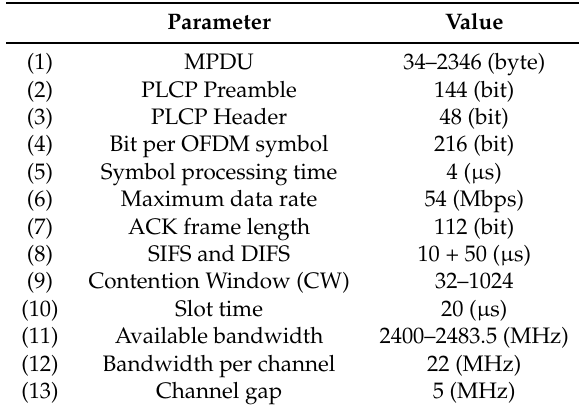
Table 1. Network parameters in the queuing model.